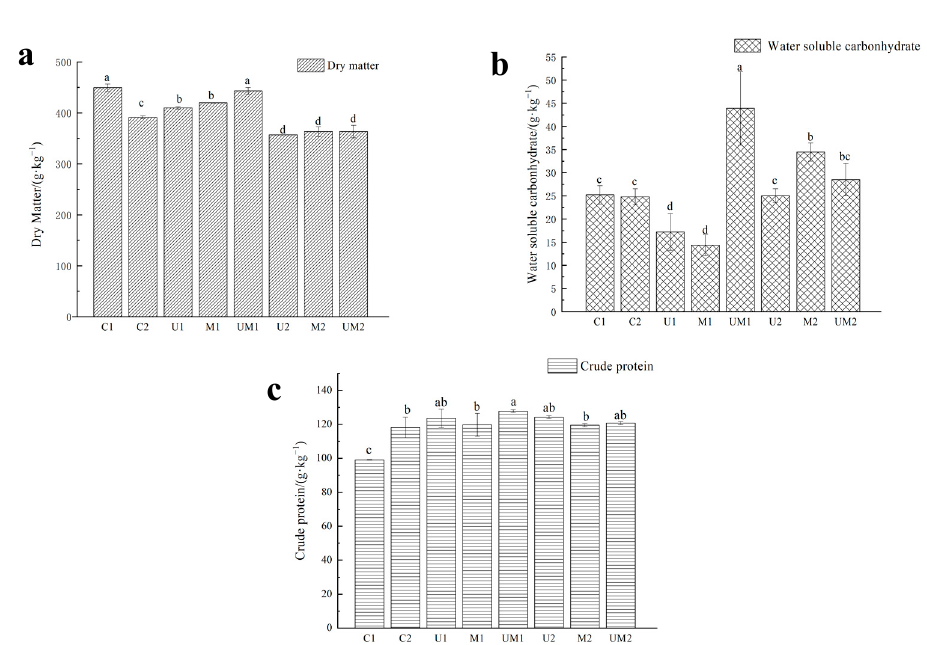
Figure 4. Effects of additives on DM ( a ), WSC ( b ) and CP ( c ) content in mixed silage. Note: C1-Rape × Alfalfa (3:7); C2-Rapeseed × M. spicatum (7:3); U1, M1 and MU1 indicate that 0.3% urea, 3% molasses, 0.3% urea and 3% molasses (all fresh weight) are successively added when rape and alfalfa (3:7) are mixed for silage. U2, M2 and MU2 indicate that 0.3% urea, 3% molasses, 0.3% urea and 3% molasses (all fresh weight) are successively added during the mixed silage of rapeseed and M. spicatum (7:3). The same below. Note: Different lowercase letters indicate significant difference between different treatment groups ( p < 0.05).